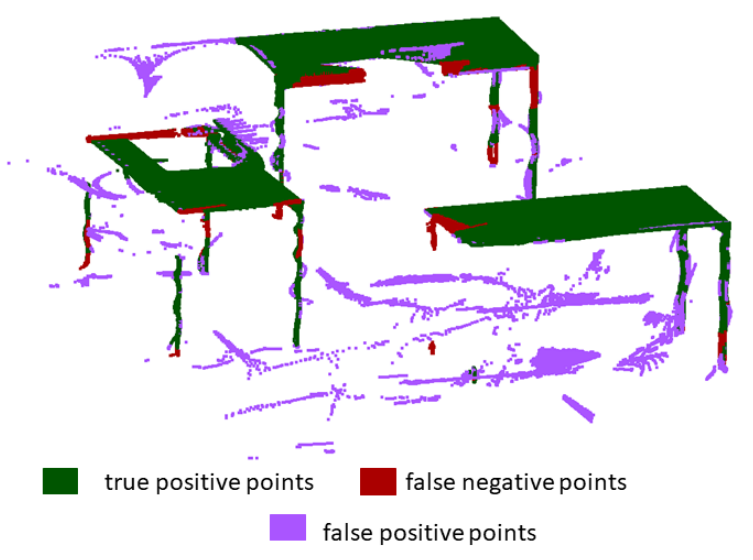
Figure 8. Segmented point cloud of the class table colored by TP, FP and FN points.